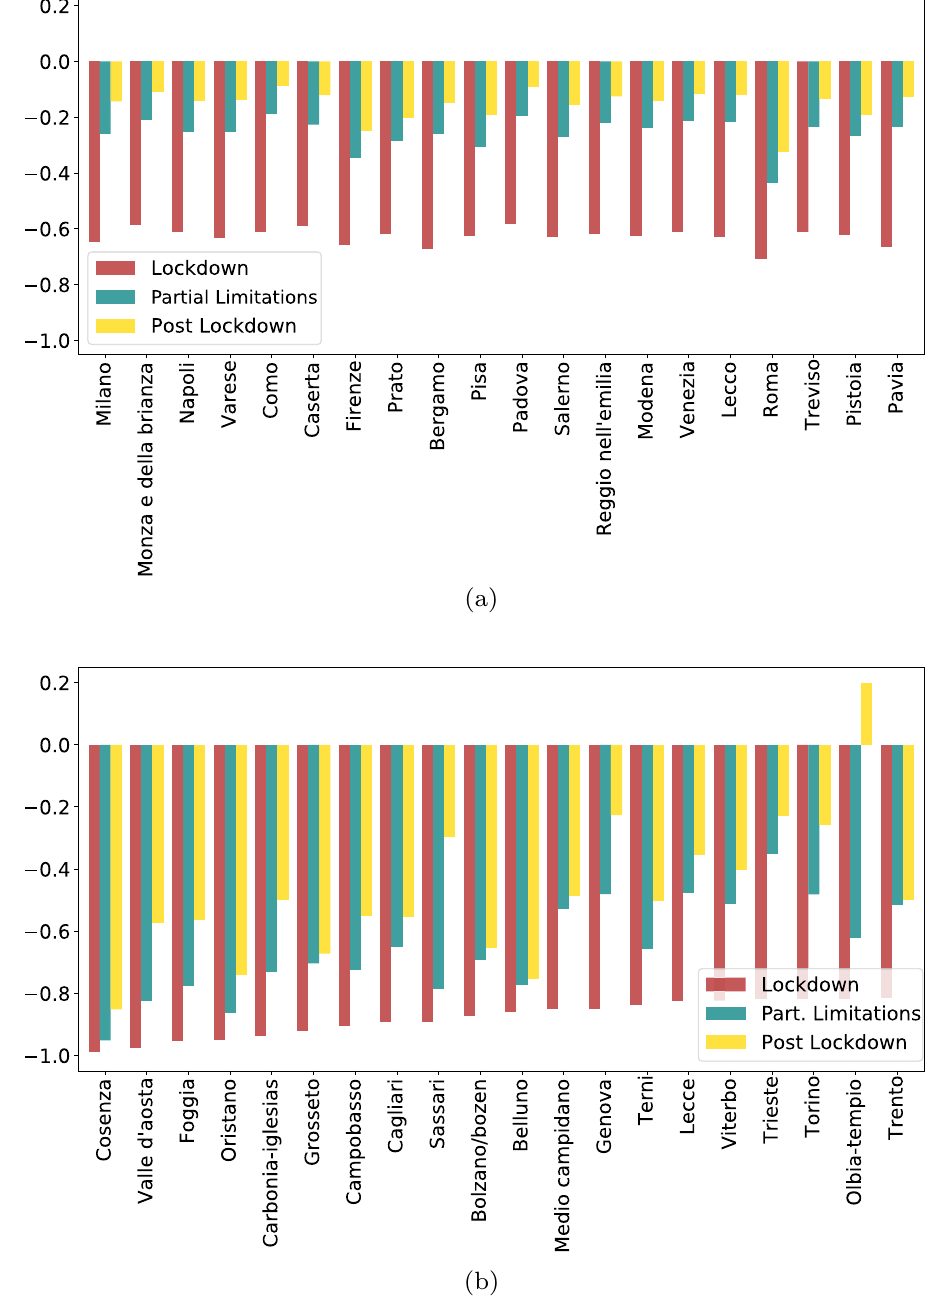
Figure 4. (Top) Most mobile-Provinces with the highest weighted degree, and (Bottom) most impacted Provinces and their recovery through partial restrictions to complete lift of